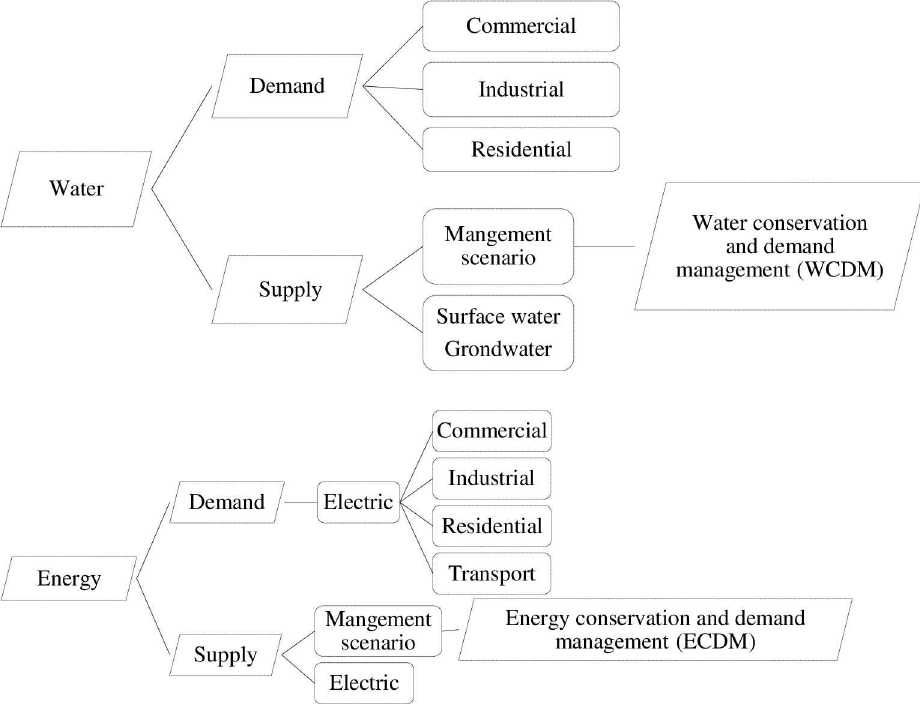
Fig 2. Framework of water-energy supply and demand